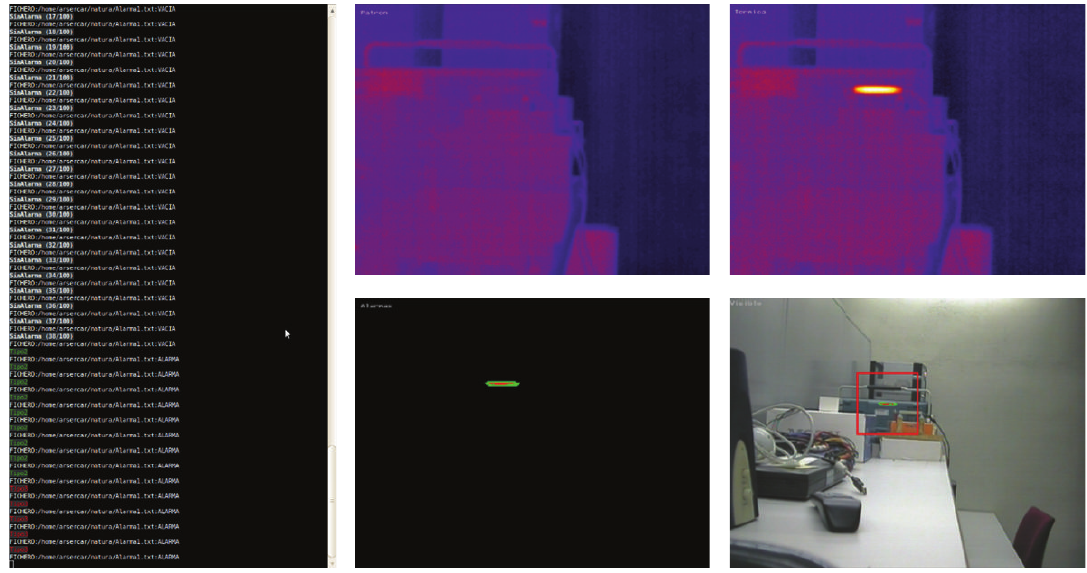
Figure 5: Capture of processing example in laboratory